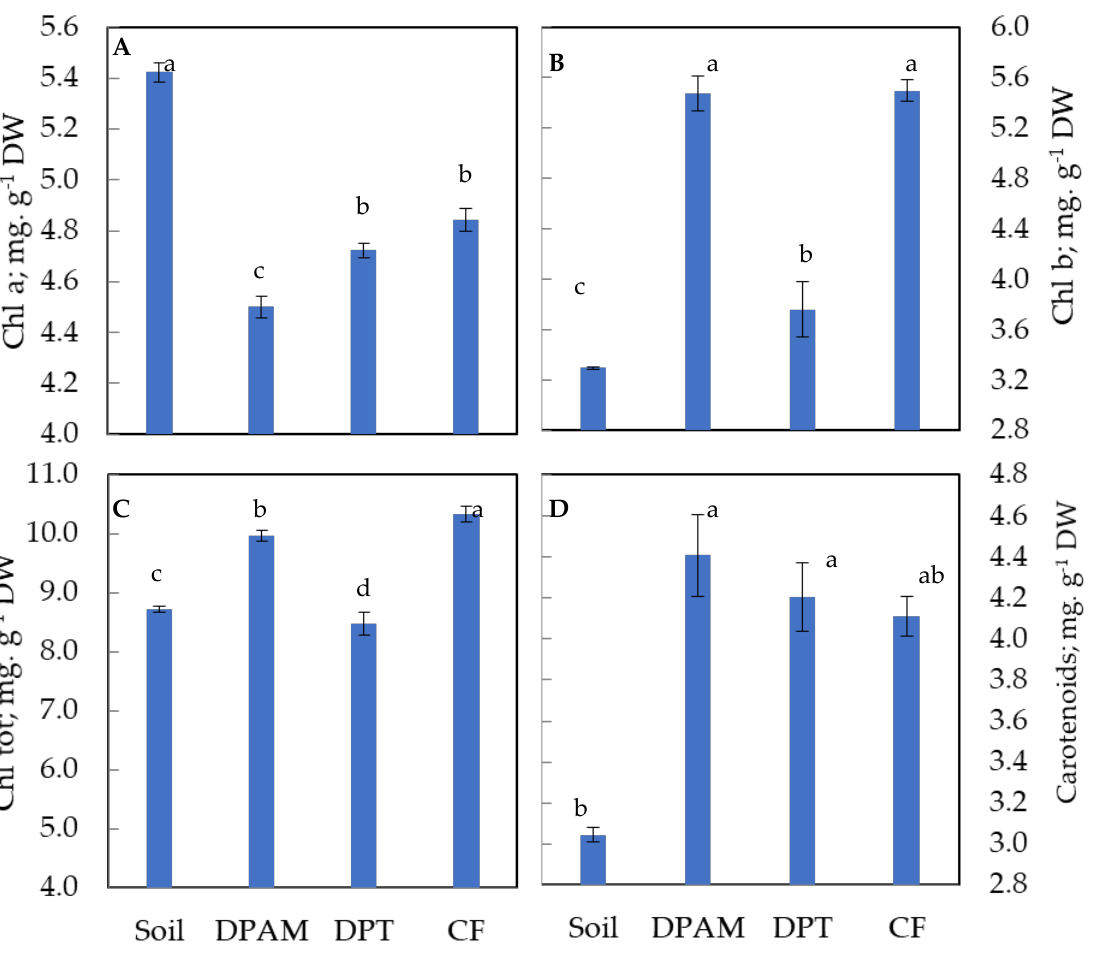
Figure 2. Variation in assimilating pigments content (mg g − 1 FW) in leaves of 4-month-old tomato plants cultivated on different substrates. DPAM: compost of date-palm residues and animal manure; DPT: compost of date-palm trunk; CF: coconut fiber, compared with soil substrate. ( A ) Chlorophyll-a; ( B ) chlorophyll-b; ( C ) total chlorophyll; ( D ) carotenoids. The results represent the means of six replicates ± SD. Vertical bars indicate standard errors of means. Numbers followed by a different letter within a panel are significantly different at p ≤ 0.05, according to LSD analysis.